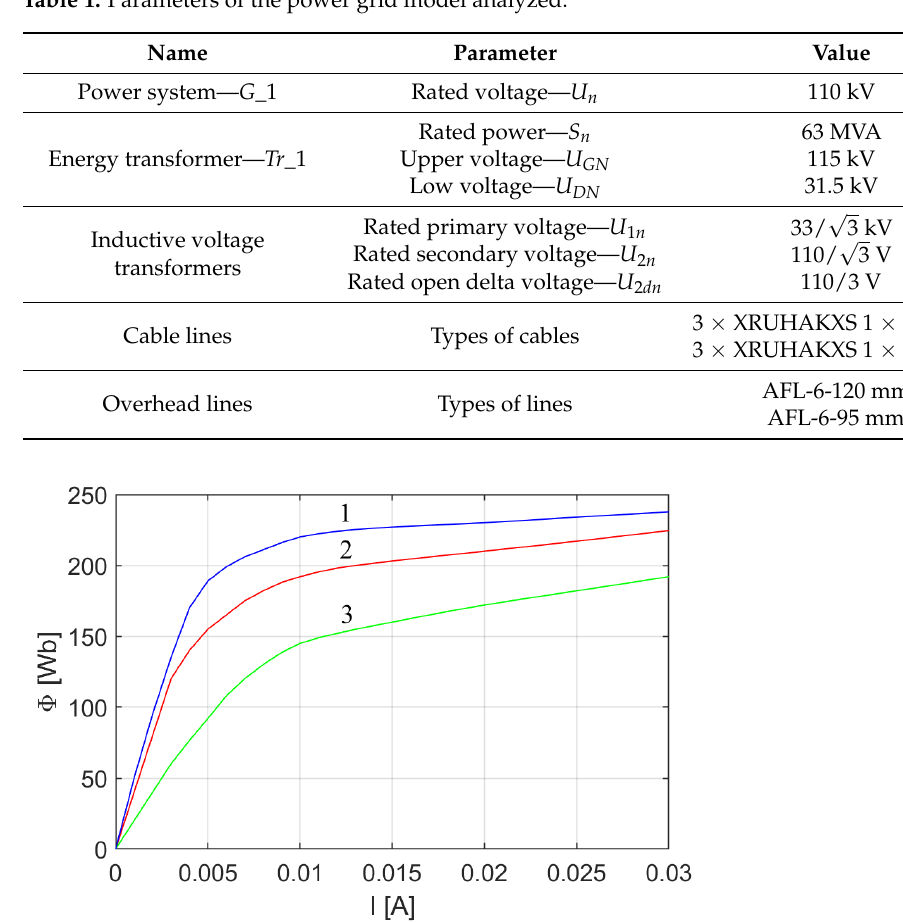
Table 1. Parameters of the power grid model analyzed.